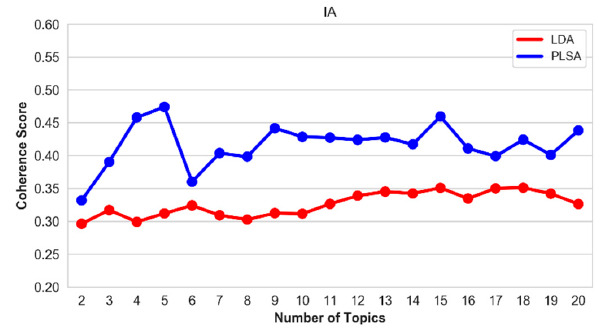
Figure 15. Coherence score of the top-20 topics on the ERI hallmark.